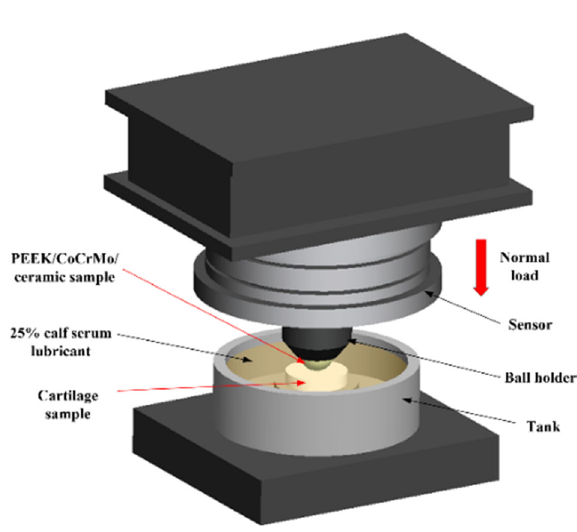
Fig. 1 The creep experimental device